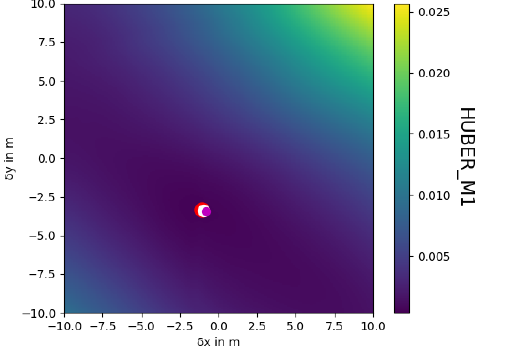
Figure 3. Example objective function for a specific tile pair (See Figure 4). While the center of the plot at 0/0 corresponds to the current and faulty navigation, the three dots represent the local solution (white), the globally consistent solution (purple), and the ground truth